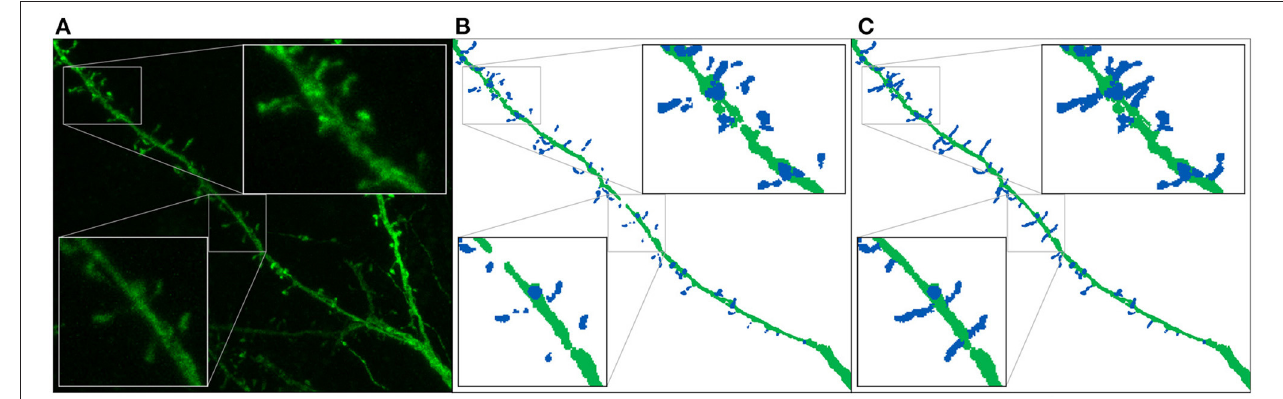
FIGURE 6 | Ground truth preparation: This image shows the maximum projection of a confocal image (A) and its corresponding annotated image before (B) and after (C) the preprocessing. We use dark blue and dark green to represent the manually segmented spines and the dendritic shaft, respectively.